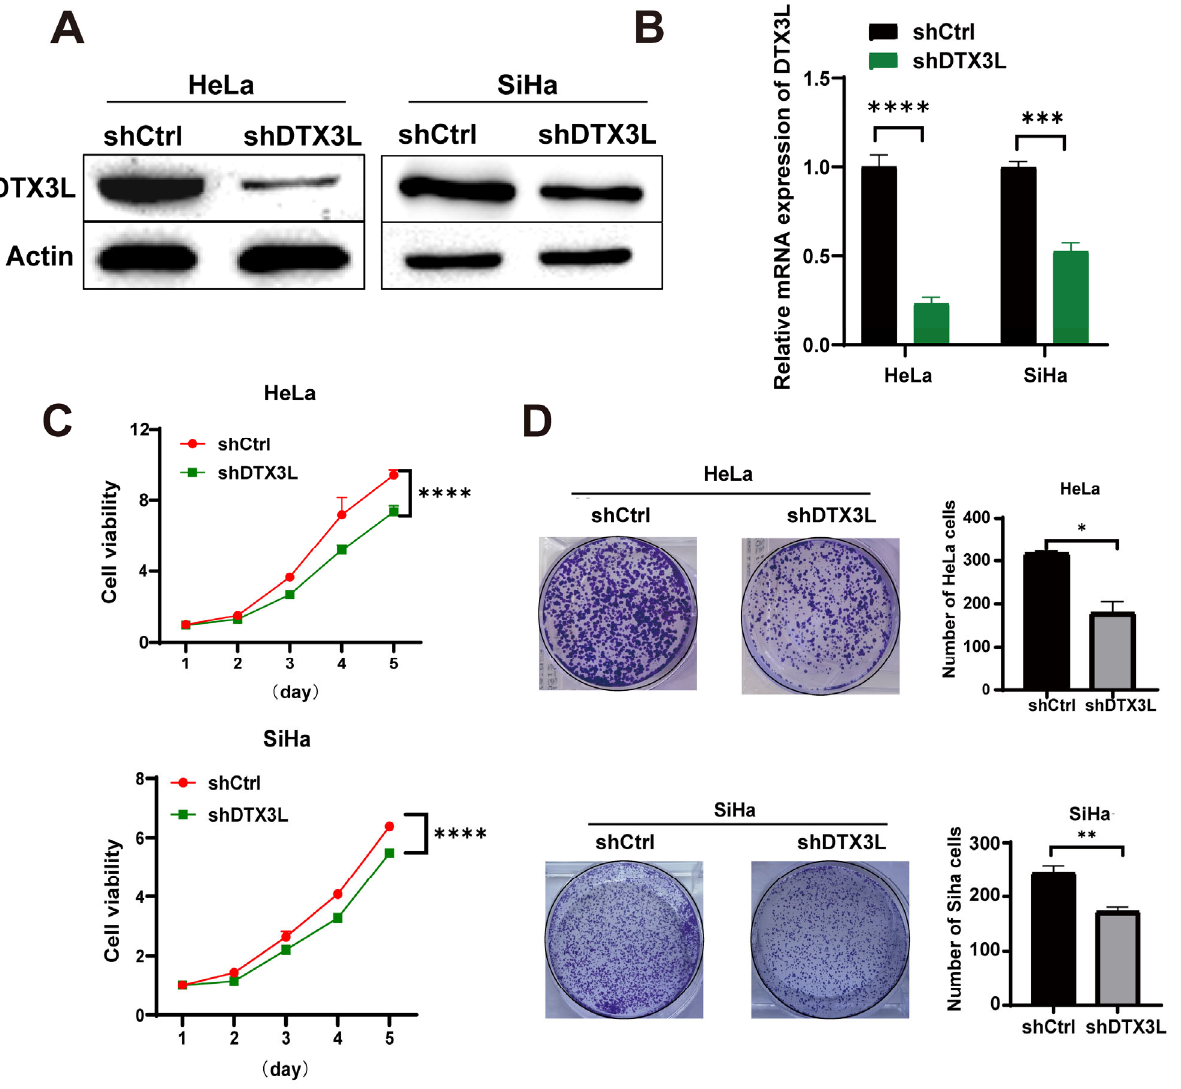
Figure 3. Knockdown of DTX3L suppressed CC cell proliferation. ( A , B ) HeLa and SiHa cells were transfected with DTX3L shRNA or control shRNA. The interference efficiencies of shDTX3L were measured by Western blot and RT ‐ qPCR analysis. ( C ) Growth curves of HeLa and SiHa cells were measured by a CCK ‐ 8 assay. ( D ) The proliferation of HeLa and SiHa cells was evaluated by colony formation, and the quantified result is shown in the right panel. * p < 0.05, ** p < 0.01, *** p < 0.001, **** p < 0.0001.